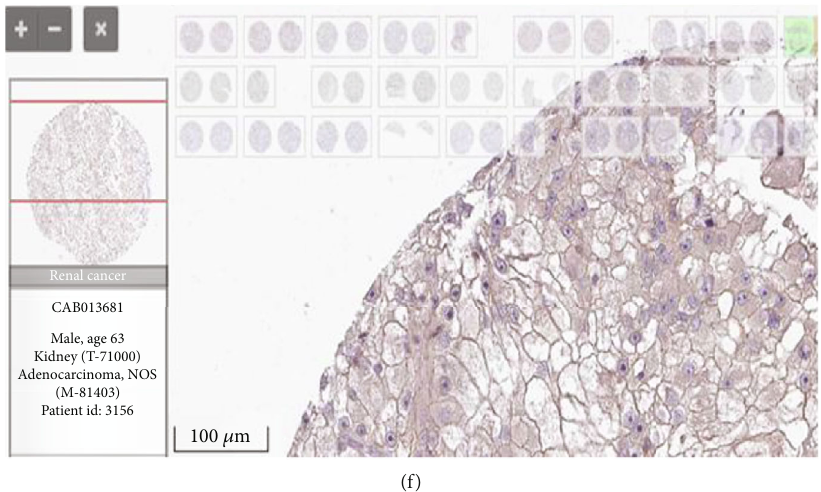
Figure 2: The mRNA and protein expression of GSDMB in ccRCC. (a) mRNA expression levels of GSDMB in 539 ccRCC samples and 72 normal samples. (b) mRNA expression levels of GSDMB in 72 ccRCC and matched-adjacent normal samples. (c) mRNA expression levels of GSDMB in 72 ccRCC and matched-adjacent normal samples in the GEO database. (d) Protein expression levels of GSDMB based on CPTAC. (e) Normal tissues: the protein levels of GSDMB based on the Human Protein Atlas. (f) Tumor tissues: the protein levels of GSDMB based on the Human Protein Atlas ( ∗∗∗ P < 0 : 001 ). ccRCC: clear cell renal cell